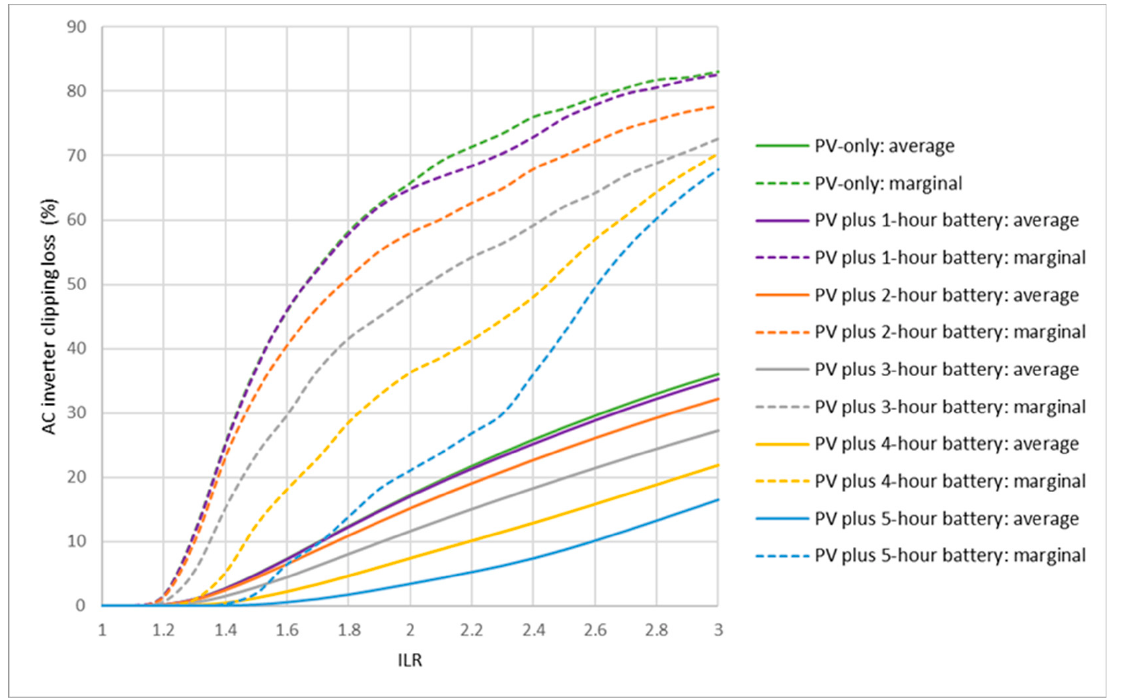
Figure 7. Variation of annual AC inverter average and marginal clipping loss for fixed-tilt systems.